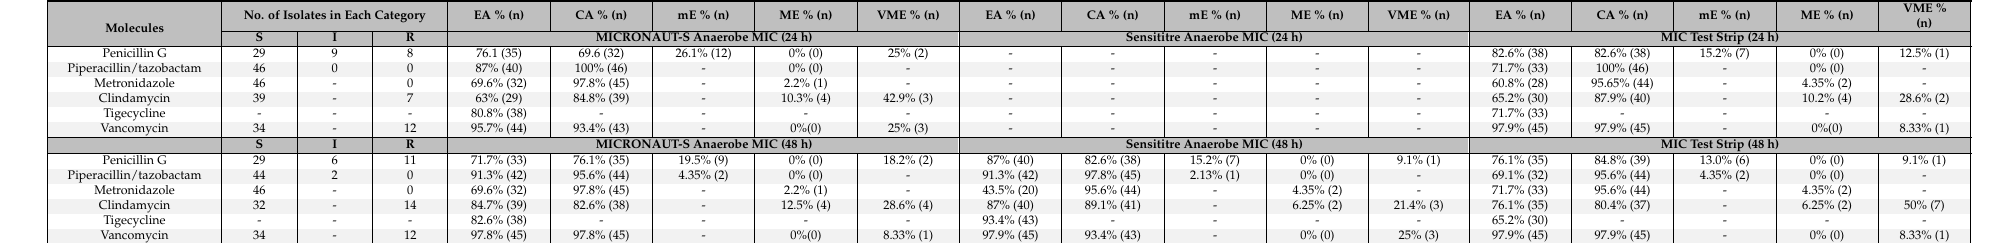
Table 2. Percentage and number of essential or categorical errors for the three methods evaluated in this study according to the reading time for the 46 studied isolates using ADM as reference method. EA: essential agreement; CA: categorical agreement; mE: minor error; ME: major error; VME: very major